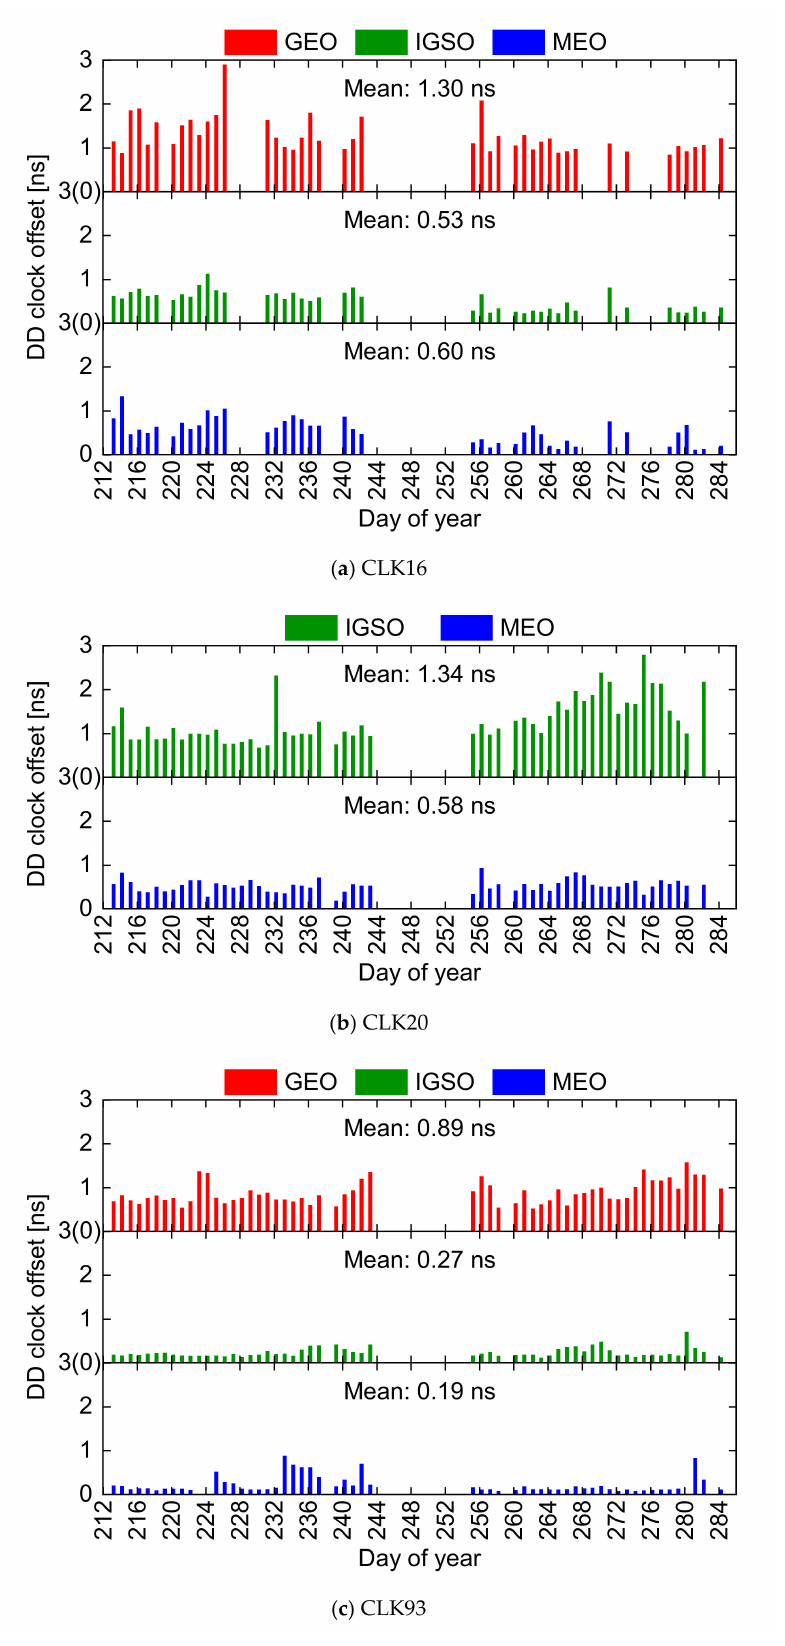
Figure 9. Daily averaged STDs of double-di ff erenced (DD) clock o ff sets for CLK16 ( a ), CLK20 ( b ), and CLK93 ( c ) from day of year 213–243 and 255–284, 2019. CLK20 does not provide GEO clock